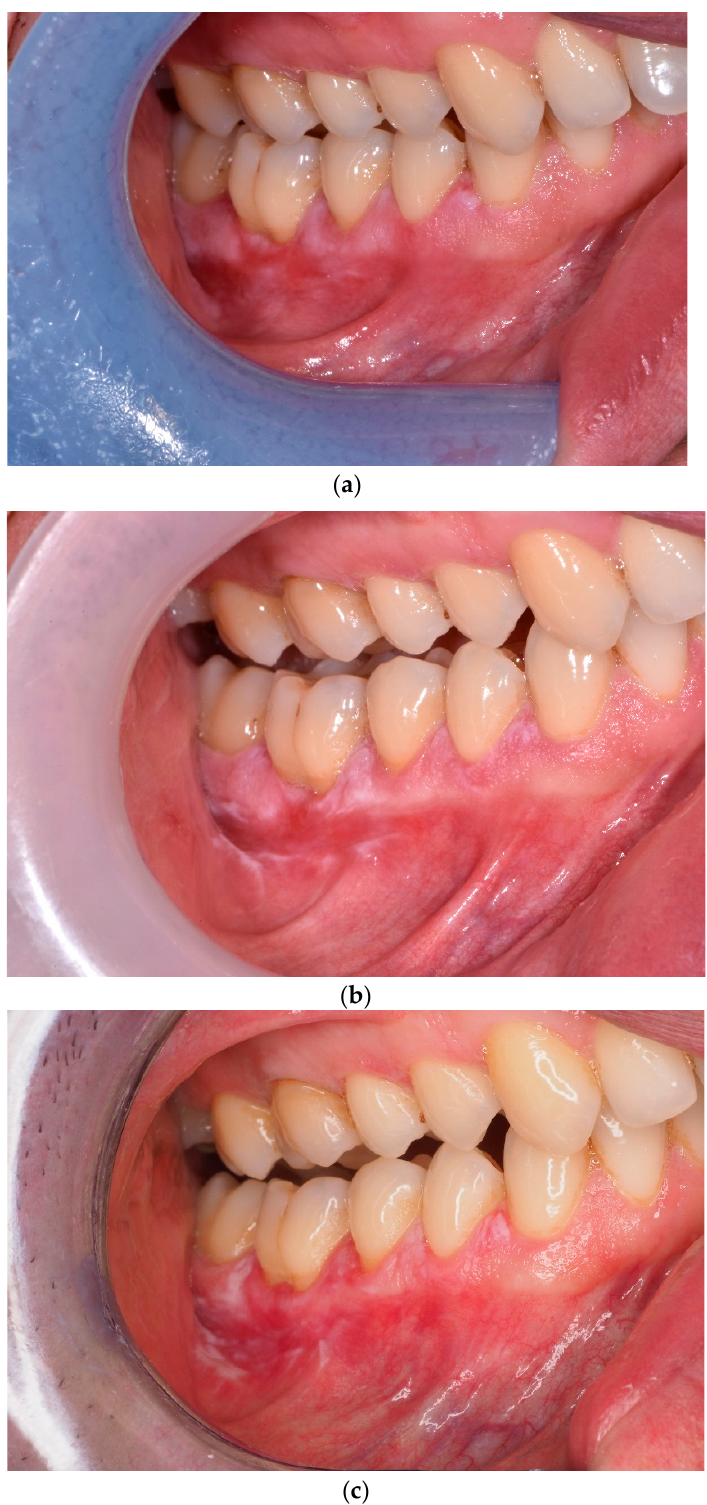
Figure 3. ( a ) Female patient, aged 44, before PDT. OLP on the right gingiva. Size of the lesion—1.1 cm × 0.7 cm; surface area 0.77 cm 2 . ( b ) After PDT—partial remission of the lesion. Size of the remain- ing lesion—1.1 cm × 0.5 cm; surface area—0.55 cm 2 . ( c ) Twelve months post-op—further improve- ment in OLP lesion. Size of the remaining lesion—0.5 cm × 0.6 cm; surface area—0.3 cm 2 .